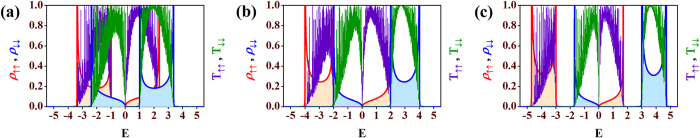
Local density of states (LDOS) and transmission characteristics for spin-up and spin-down electrons.Plots of local density of states (LDOS) and transmission probabilities vs. energy E for the spin up and spin down electrons for three values of h with θn = 0 (∀n) and Φ = 0. The orange shaded plot with red envelope is the LDOS for the spin up (↑) states and the light blue shaded plot with blue envelope is the LDOS for the spin down (↓) states. The violet lines represent the transmission characteristics for the spin up (↑) particles while the green lines correspond to the transmission for the spin down (↓) particles for (a) h = 1, (b) h = 2, and (c) h = 3. Also, we set  =  (∀n) and τ = 1.